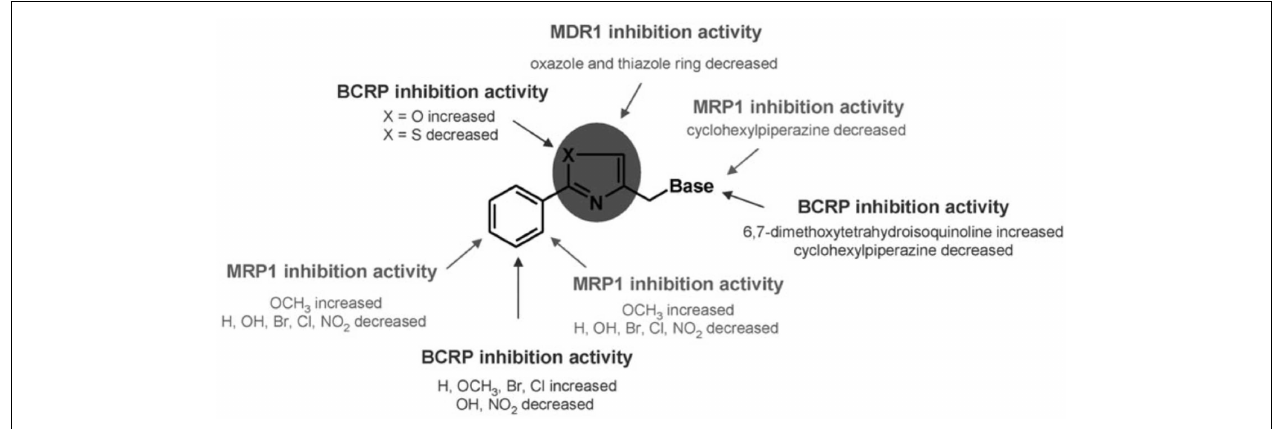
FIGURE 7 | SAR studies of aryloxazole and arylthiazole derivatives . Picture reported in Ref.